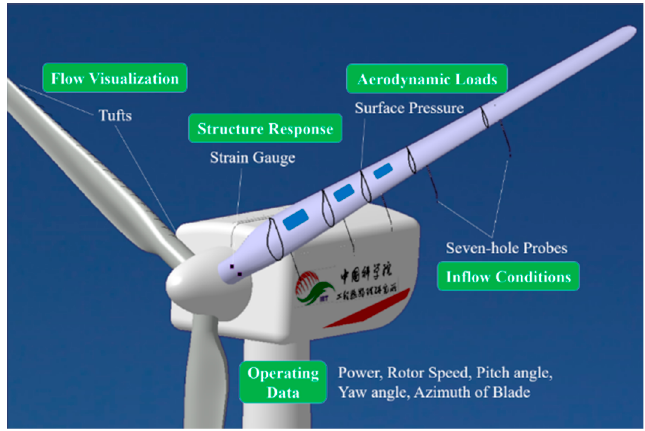
Figure 3. Overall layout of field measurement platform.